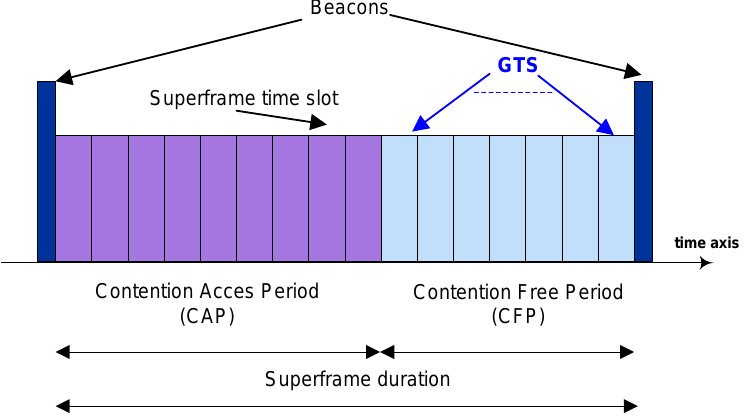
Figure 2. IEEE 802.15.4 MAC superframe structure in beacon-enabled mode